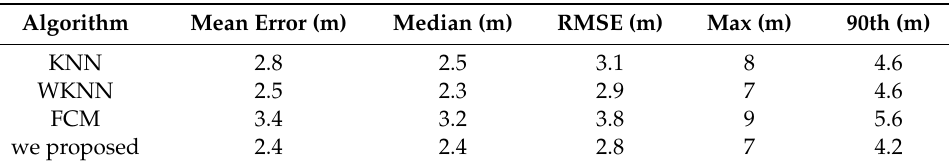
Table 9. Comparison of positioning error.